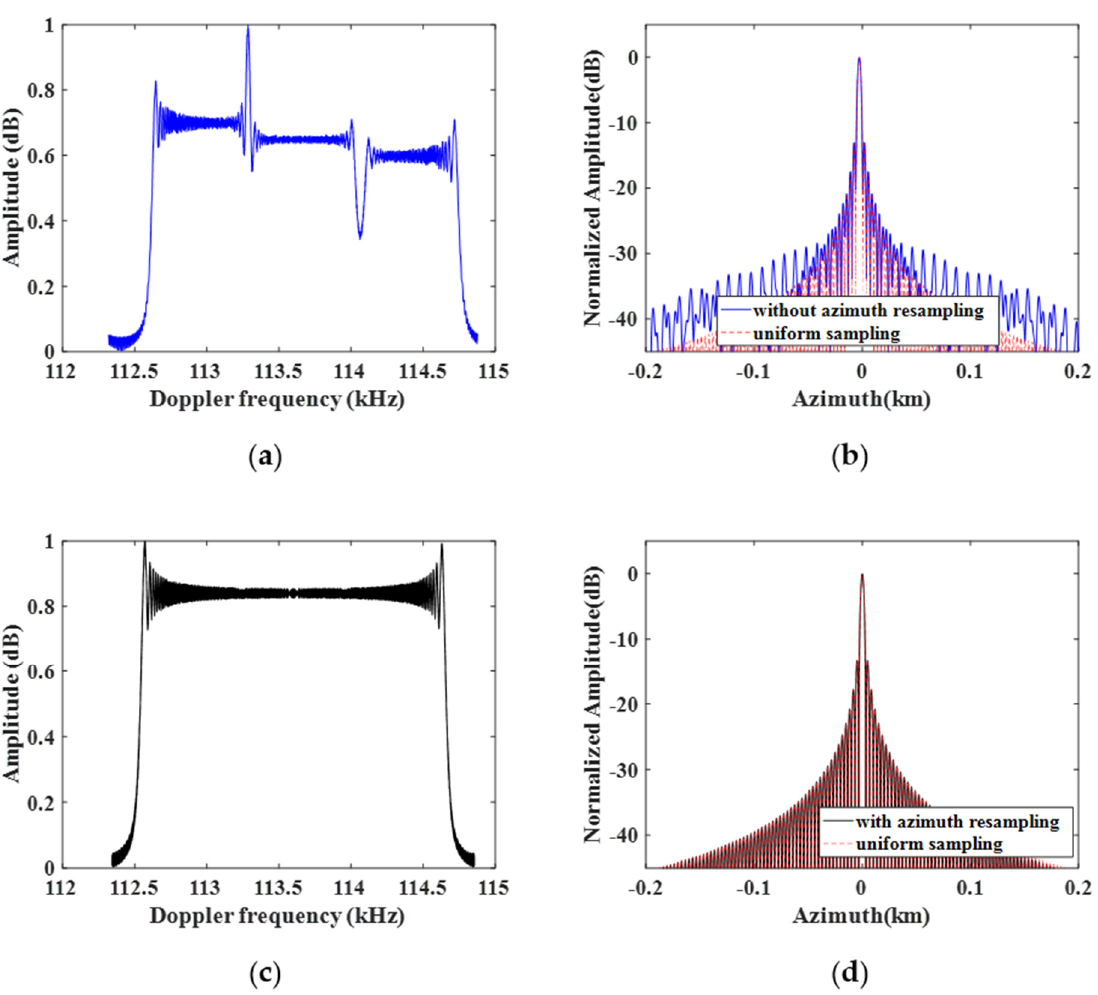
Figure 12. One-dimensional azimuth compression results of the proposed method. ( a ) Azimuth spec- trum without azimuth resampling; ( b ) the azimuth compression result of ( a ); ( c ) Doppler spectrum after azimuth resampling; ( d ) the azimuth compression result of ( c